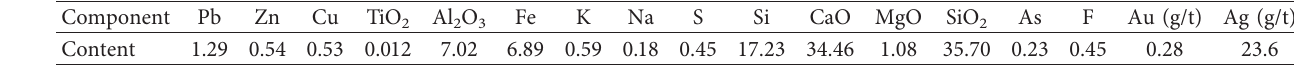
Table 1: Chemical multiple element analysis of raw ore (%).